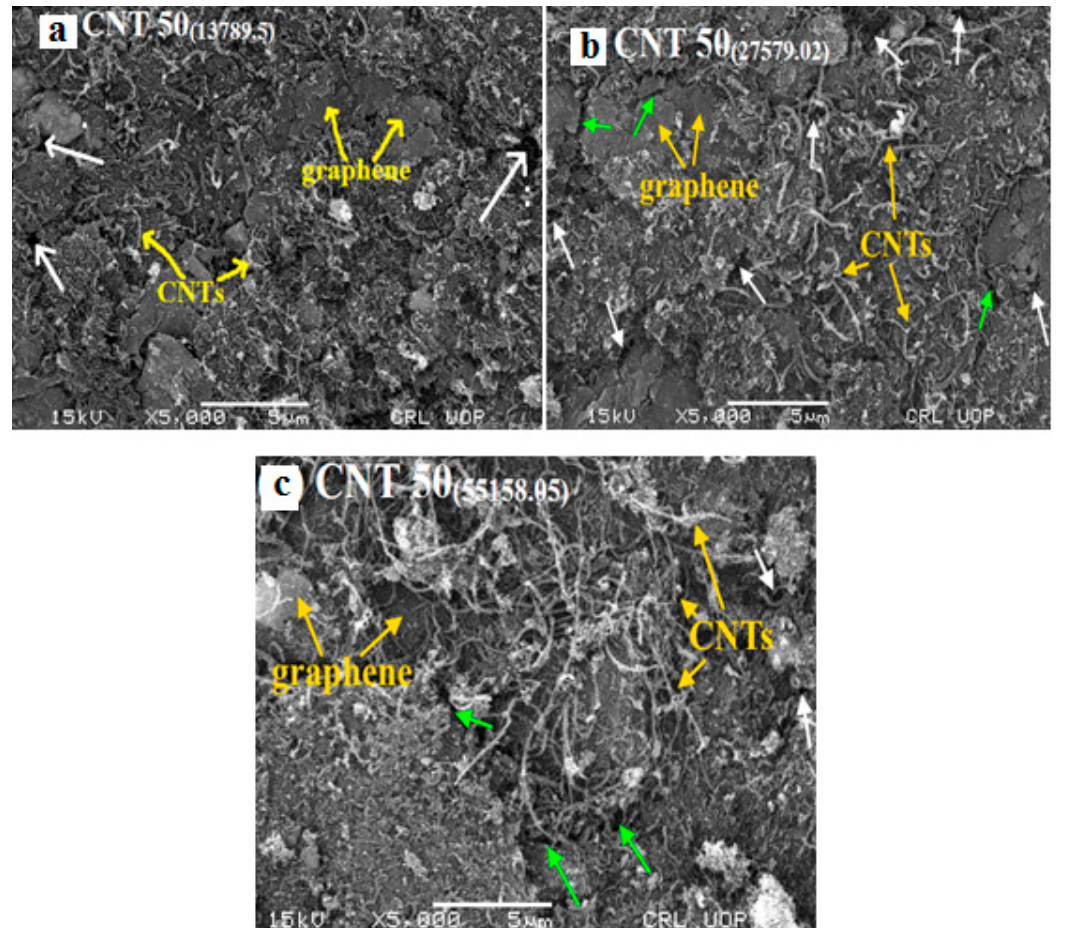
Figure 5. SEM images of the fabricated sensors with different fabrication pressure of ( a ) 13,789.5, ( b ) 27,579.02, and ( c ) 55,158.05 kNm − 2 .